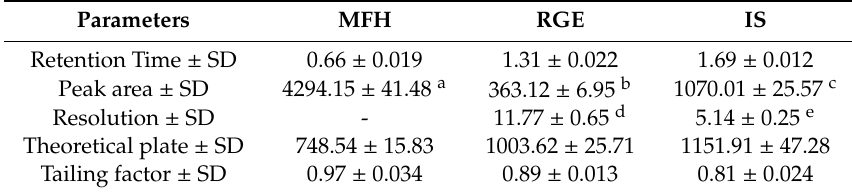
Table 2. System suitability results for analytes by RP HPLC method.